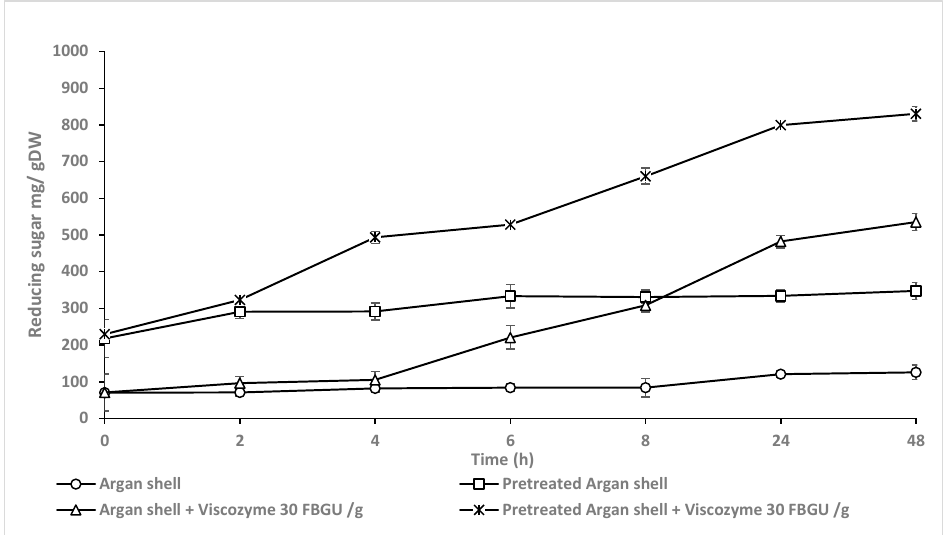
Figure 3. Analysis of enzymatic hydrolysis of argan shell at 2% w / v using Viscozyme L (30 FBGU/g).